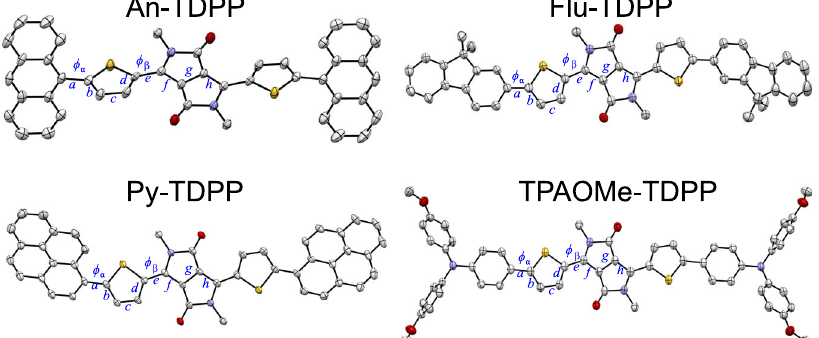
Fig. 5 Solid-state structures by XRD. ORTEP drawings with side-chains and hydrogen atoms omitted for clarity. Thermal ellipsoids are drawn at 50% probability. Selected bond lengths (A ̊ ) and dihedral angles ( ϕ ) for An-TDPP, Flu-TDPP, Py-TDPP, and TPAOMe-TDPP, respectively: ϕ α (86.6°, 2.78°, 40.7°, 14.4°), ϕ β (13.9°, 11.4°, 5.71°, 5.17°), a (1.475, 1.464, 1.469, 1.461), b (1.356, 1.369, 1.380, 1.367), c (1.403, 1.400, 1.396, 1.397), d (1.371, 1.372, 1.385, 1.376), e (1.442, 1.443, 1.432, 1.437), f (1.388, 1.384, 1.387, 1.404), g (1.408, 1.408, 1.412, 1.406), h (1.388, 1.386, 1.403,